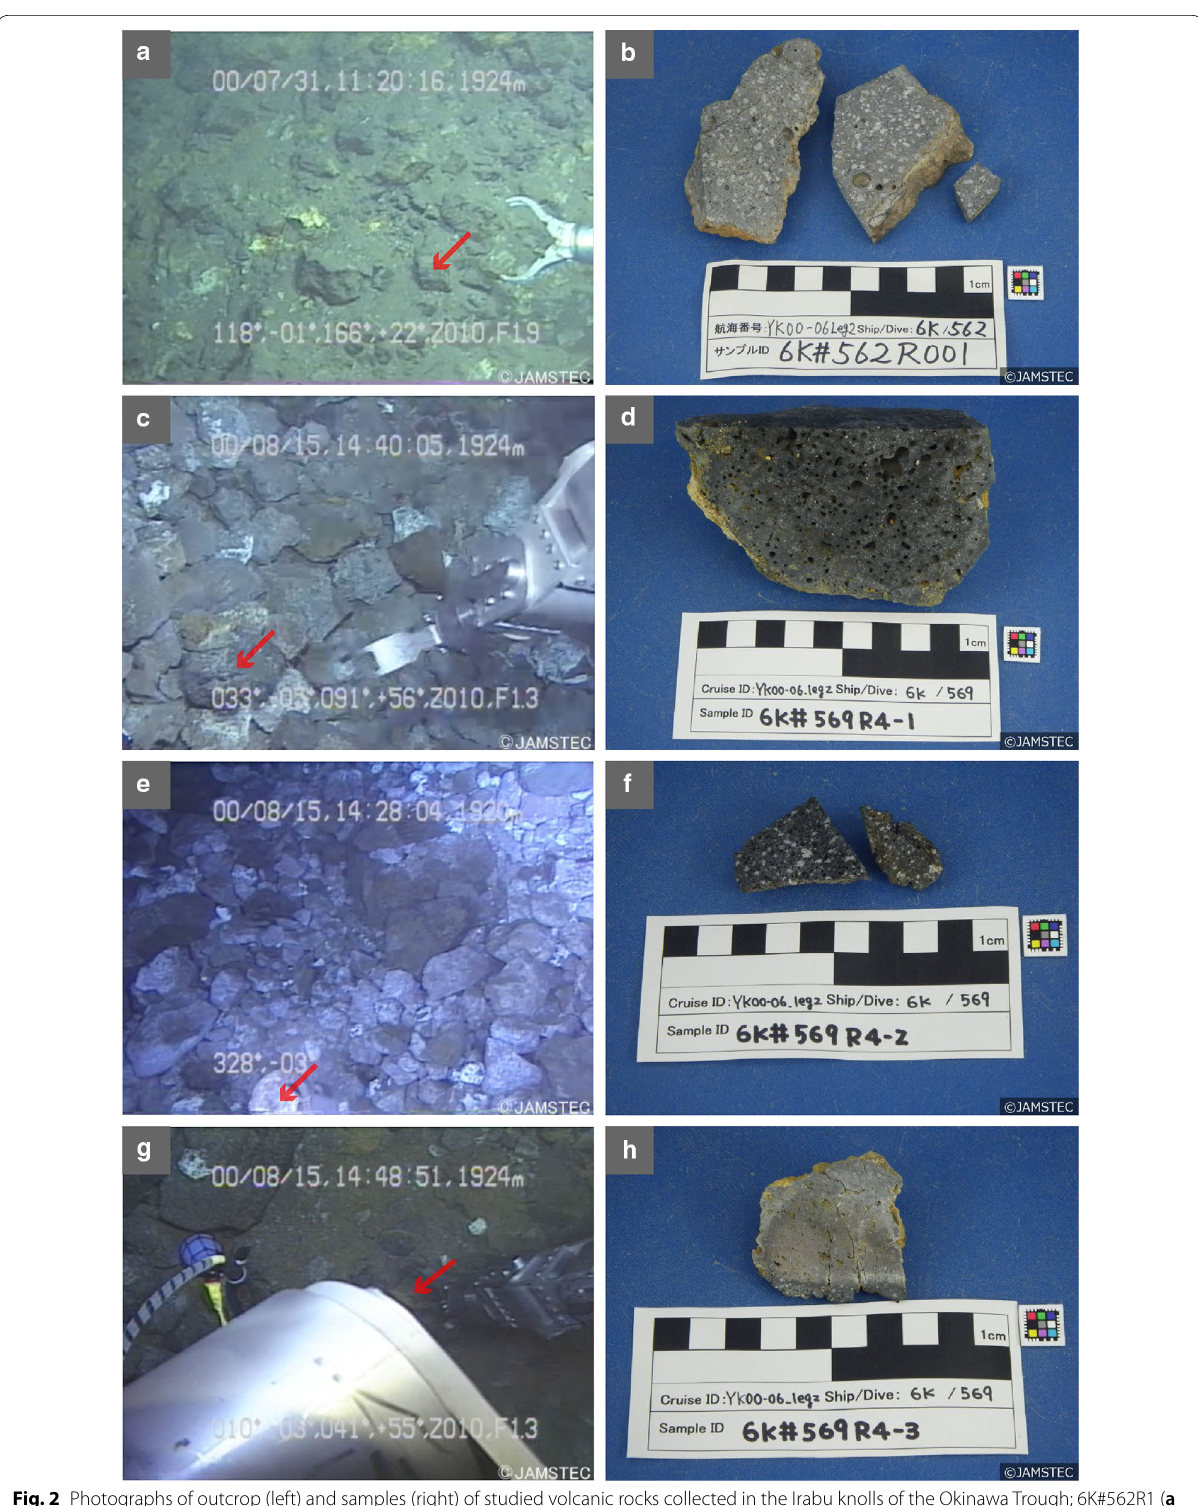
Fig. 2 Photographs of outcrop (left) and samples (right) of studied volcanic rocks collected in the Irabu knolls of the Okinawa Trough; 6K#562R1 ( a and b ), 6K#569R4‑1 ( c and d ), 6K#569R4‑2 ( e and f ), and 6K#569R4‑3 ( g and h